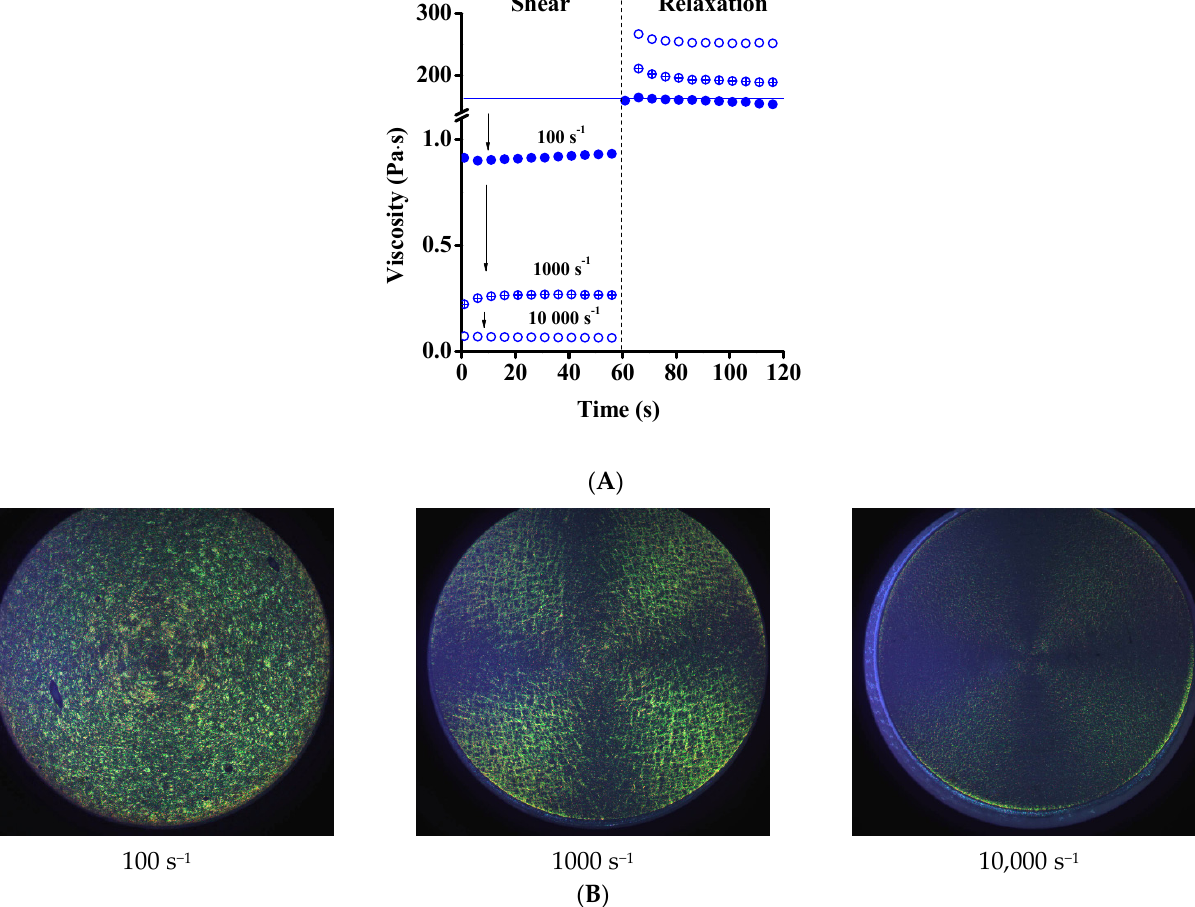
Figure 8. Change of viscosity of fresh GO suspensions under high shear followed by relaxation at low shear rate ( A ). Three consecutive experiments were performed with a shear rate of 100, 1000 and 10,000 s − 1 for 60 s in each case in the first part, and 0.1 s − 1 for relaxation (60 s). Polarized light images of GO suspensions at rest after shearing with different shear rates ( B ).